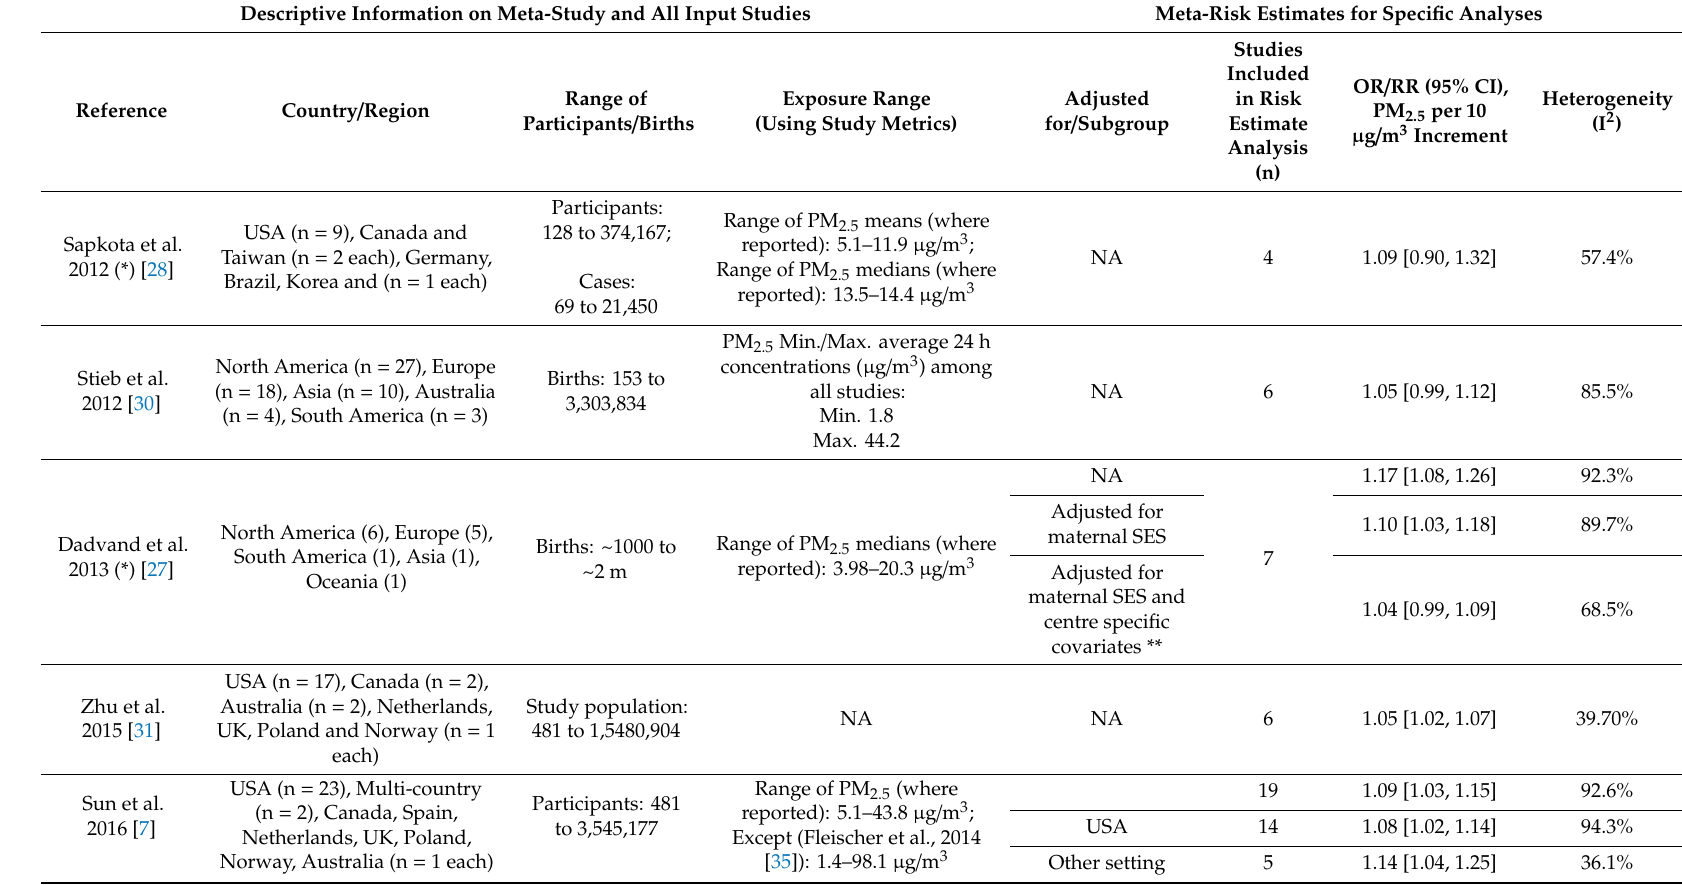
Table 1. Meta-analyses results for LBW or term low birth weight (TLBW) (*) and PM 2.5 exposure during the entire